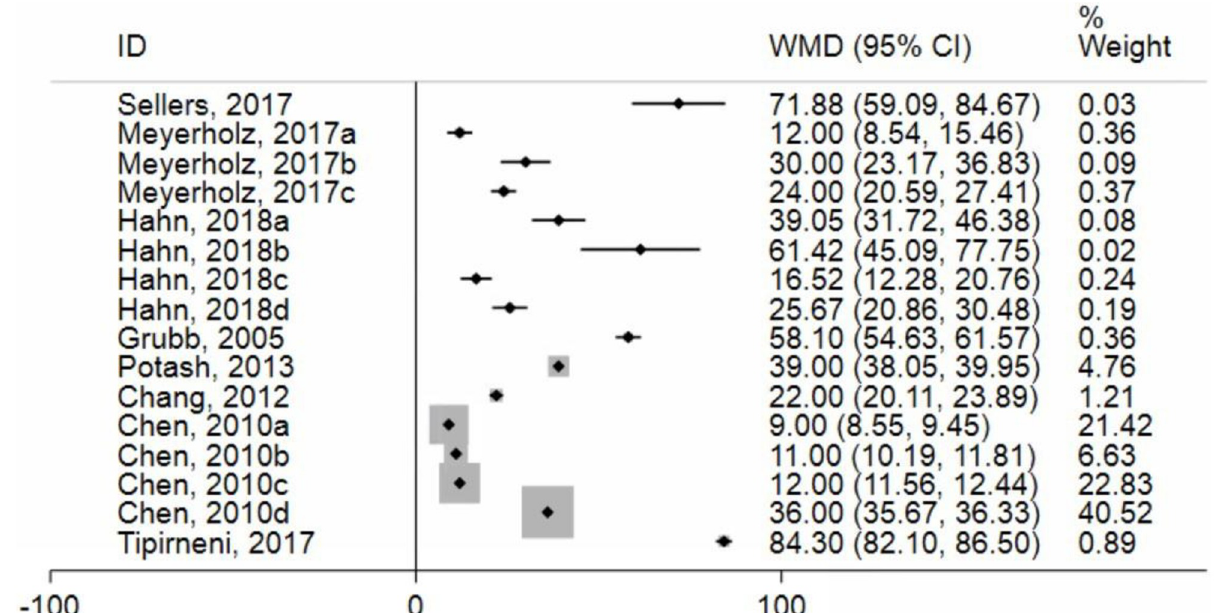
Fig 3. Forest plot of included animal models studies. References: Sellers [27]; Meyerholz [26]; Hahn [25]; Grubb [31]; Potash [33]; Chang [34]; Chen [35]; Tipirneni [32]; Suzuki [28]; Hawkins [30]; Crane [29].